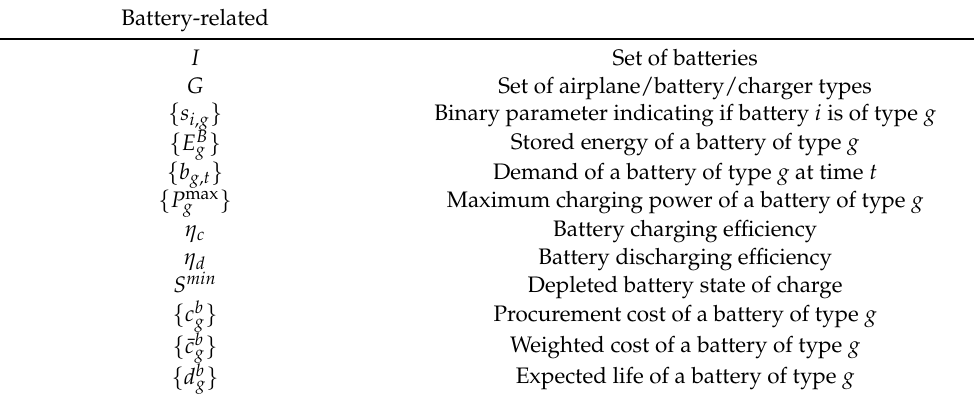
Table 3. ARES input